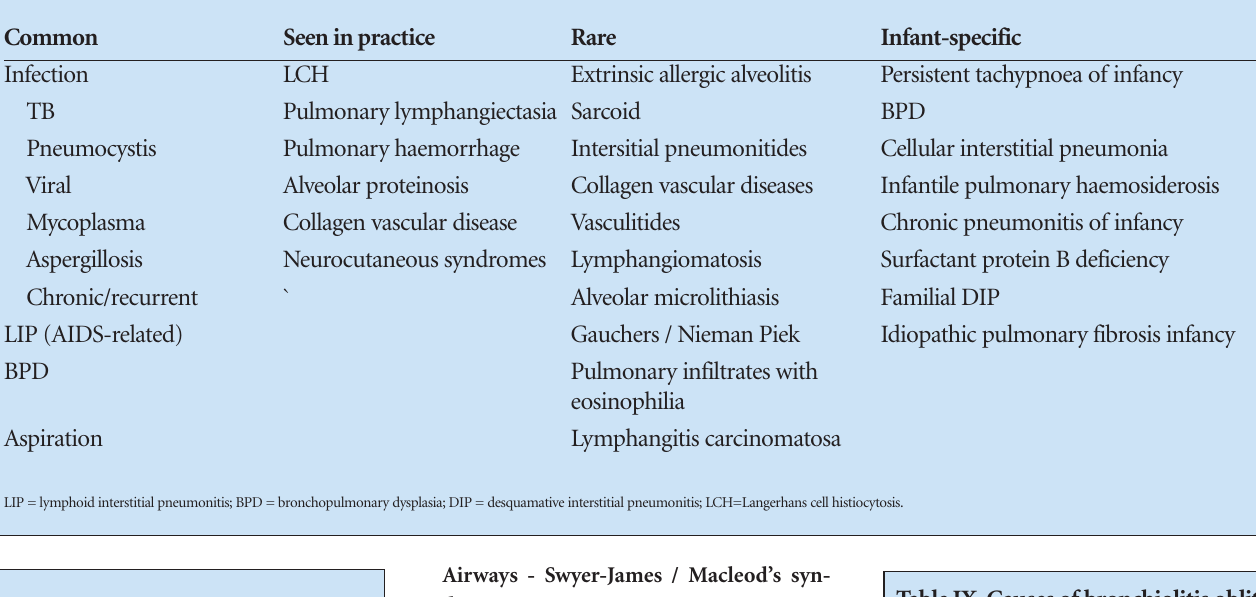
Table VIII.Airway diseases in Table IX.Causes of bronchiolitis oblit-